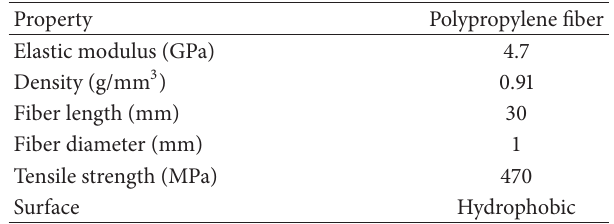
Table 4: Properties of macro polypropylene